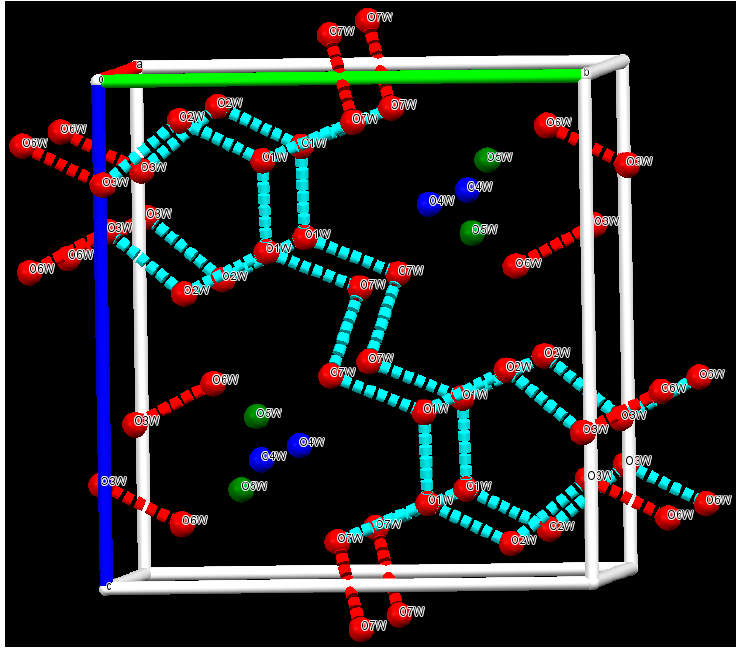
Figure 2. View of the anion water cluster polymer [(H 2 O) 18 (OH) 2 ] n 2 n − along the pc plane, which is like trans -1,6-poly(3,4-dimethyl phenylethylene) structure. O4w and O5w are the outside of water cluster polymer.